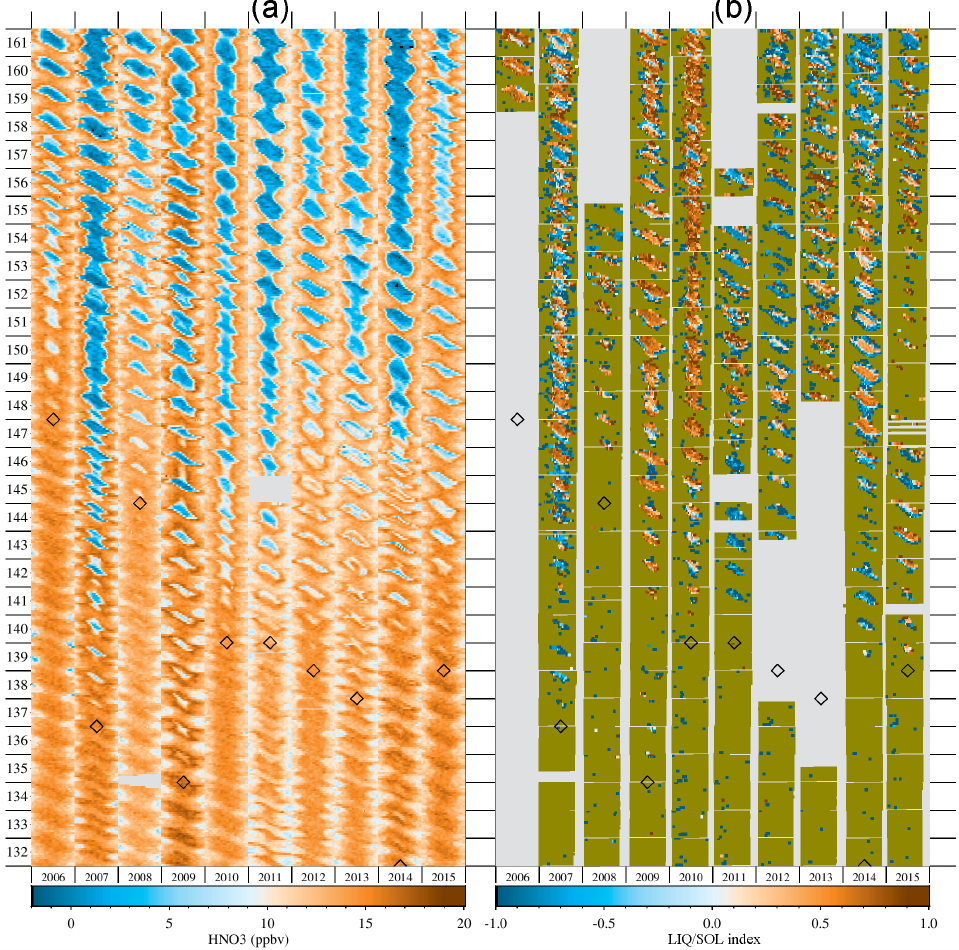
Figure 13. Thirty-day time series of Antarctic raster plots at 32hPa for 2006–2015. Diamond symbols indicate the last day before the start of detectable HNO 3 depletion. Gray shading indicates no observations; olive-green shading indicates observations but no detections. Day number is shown on the vertical axis. (a) MLS gas-phase HNO 3 . (b) CALIOP LS_index